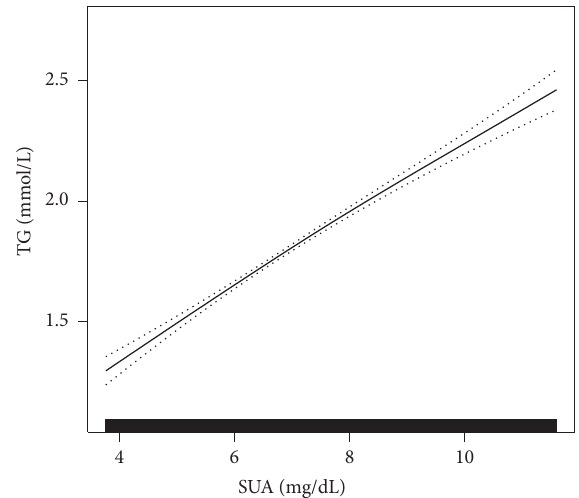
Figure 1: The positive association between SUA and TG in a hypertensive population. Adjusted for age, sex, smoking, alcohol use, stroke, diabetes, antihypertensive drugs, lipid-lowering drugs, glucose-lowering drugs, BMI, SBP, DBP, Hcy, FBG, and eGFR.